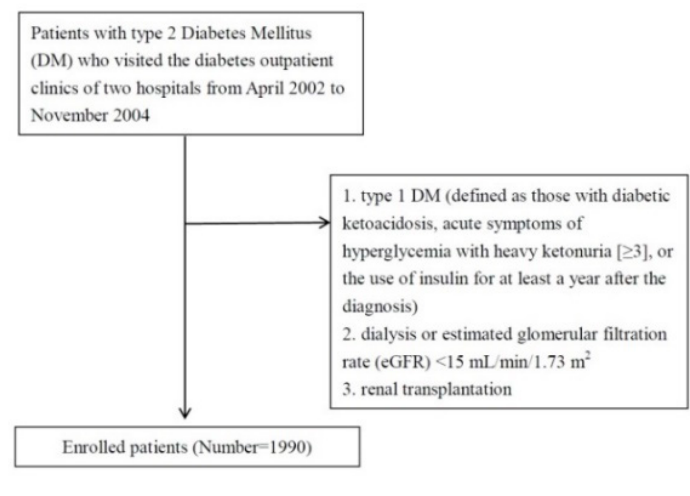
Figure 1. Figure 1. Flowchart.